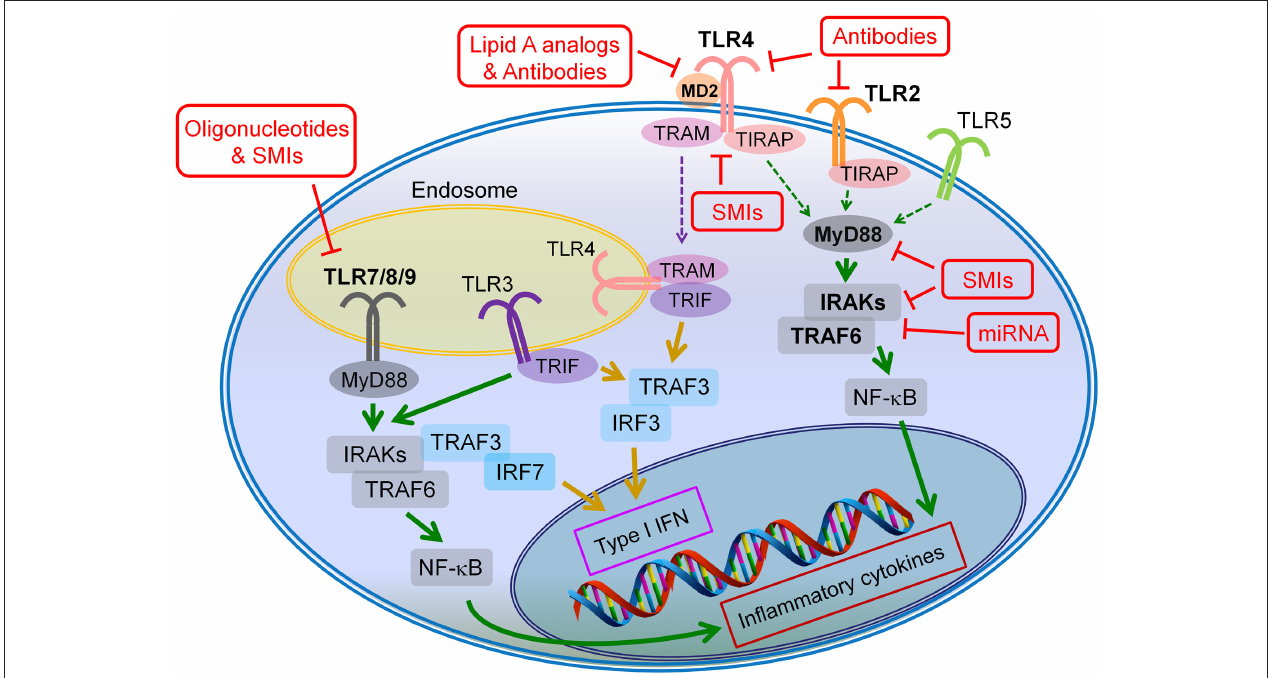
FIGURE 2 | Potential drug targets of TLR signaling pathways. The TLR inhibition can be achieved through two major strategies: (1) blocking the binding of the agonists to the corresponding TLRs, and (2) inhibiting the intracellular signaling of the TLR pathways. The antibodies, lipid A analogs and oligonucleotides primarily target at the ligand-receptor binding, whereas the microRNAs (miRNAs) mainly act on the intracellular signaling cascades of TLR pathways; the small molecule inhibitors (SMIs) can inhibitor TLR signaling through both strategies.